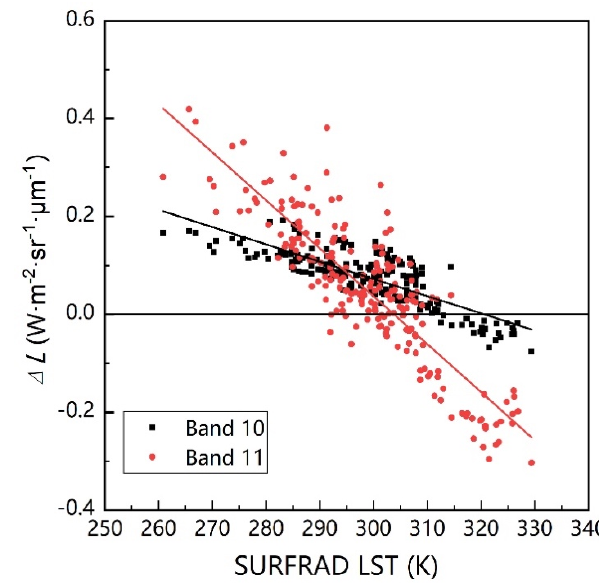
Figure 2. Relationship between ∆ L and SURFRAD LST over ground